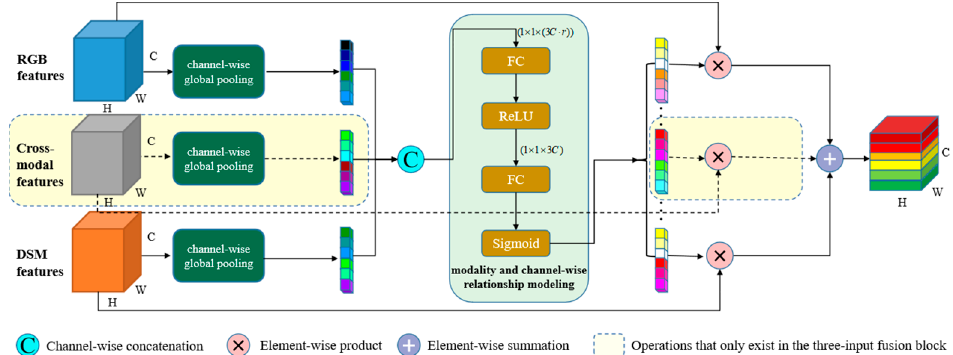
Figure 3. Att-MFBlock: attention-aware multimodal Fusion Block. Different colors of the vector elements indicate the different values of the channel-wise statistics or learned weights of each modality.